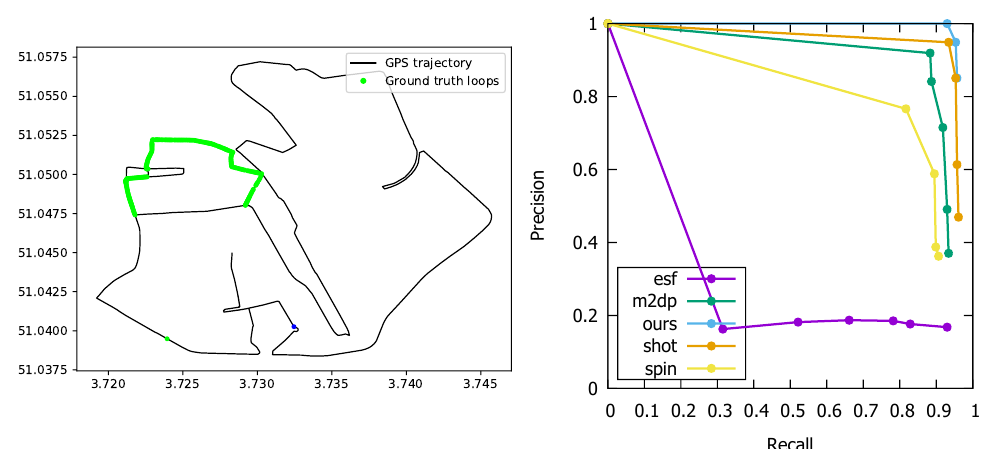
Figure 7. Left: The ground truth and estimated loops of the sequences recorded in the city center of Ghent, Belgium. We consider a loop to be present when the distance between two poses is less than 3 m. Right: The ROC curve for the sequence recorded in the city center of Ghent, Belgium. Our loop detector clearly outperformed the other methods. For a recall of 93%, we still obtained a precision of 100%, which is a 5.2% gain compared to the SHOT descriptor. The latter along with the M2DP descriptor were the only two other point cloud matchers that produced acceptable results. The loop detection quality of the spin images descriptor and ESF are too limited.